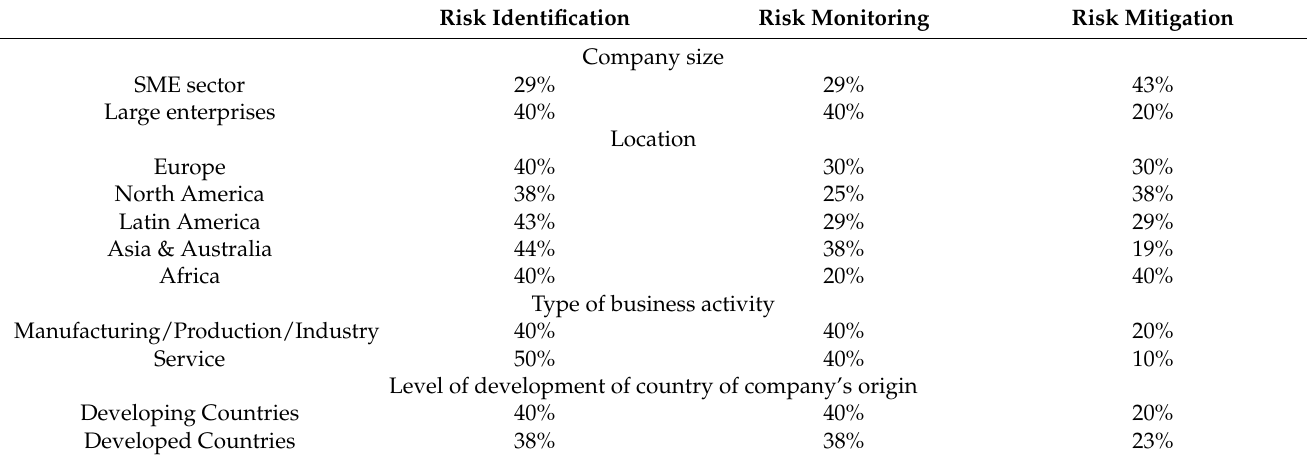
Table 8. ESG risk management activities and companies’ characteristics.